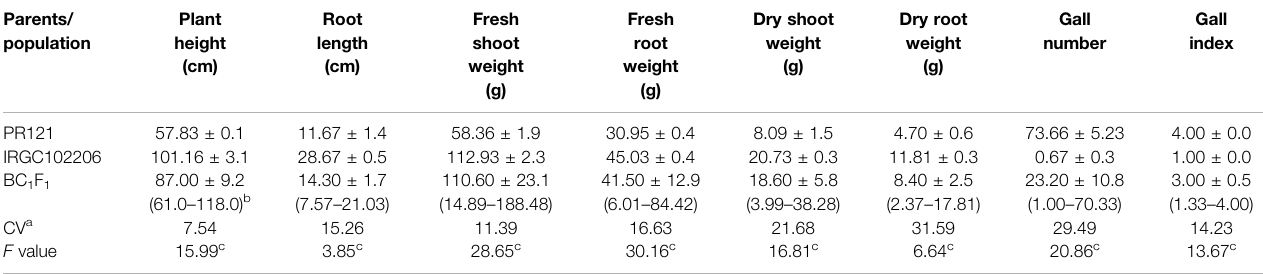
TABLE 2 | Means of growth parameters, gall number, and gall index of parents and BC 1 F 1 population derived from the cross of PR121 (S) and O. glaberrima acc. IRGC102206 (R) in nematode-infested conditions. Parents/